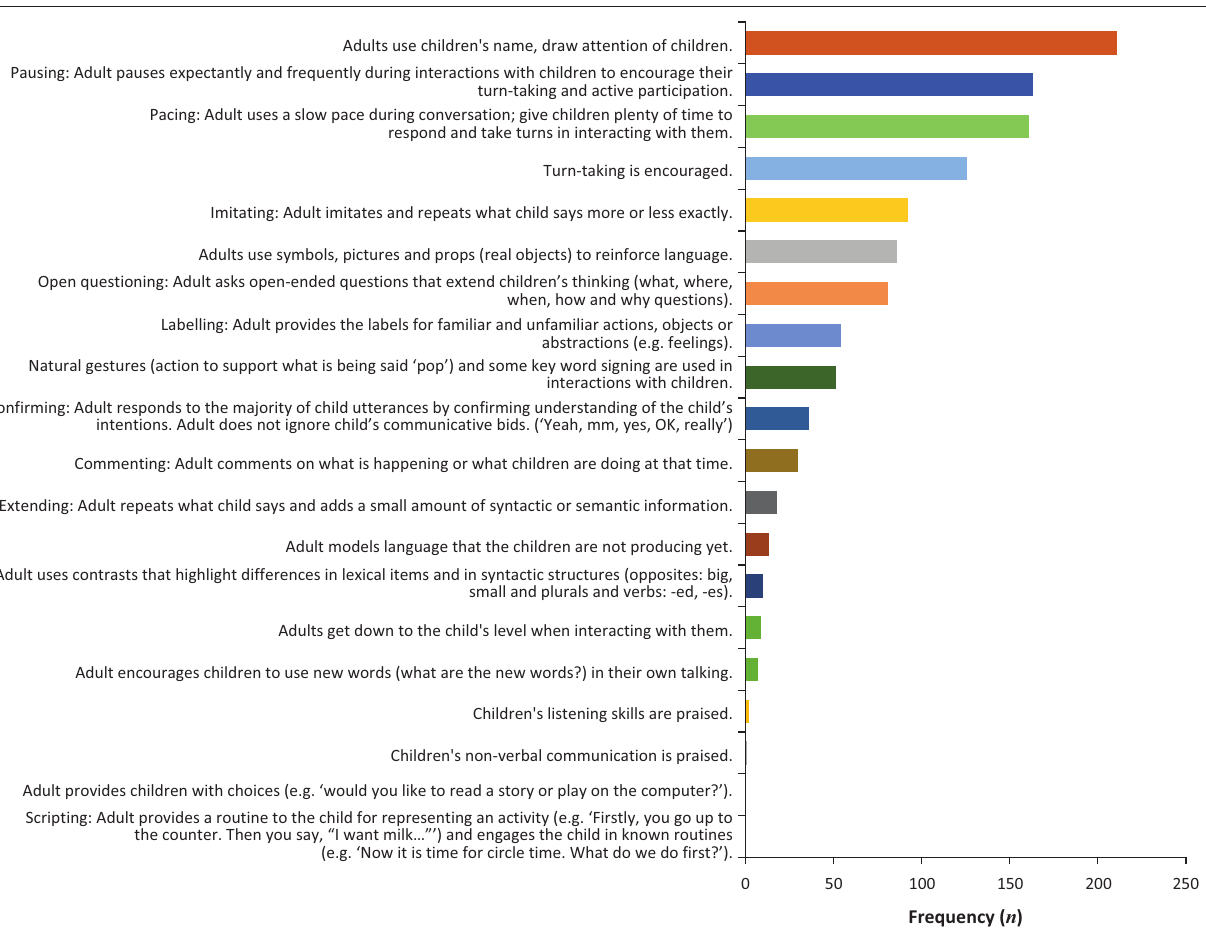
FIGURE 3: Frequency of items observed – Language-learning interactions (> 4).